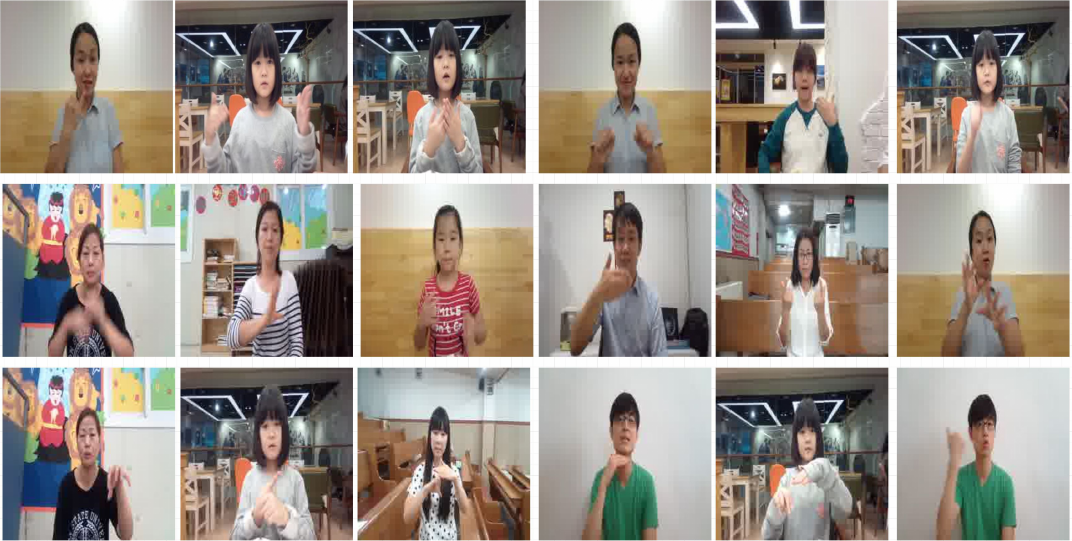
Figure 1. Example of KSL image from 77 class KSL